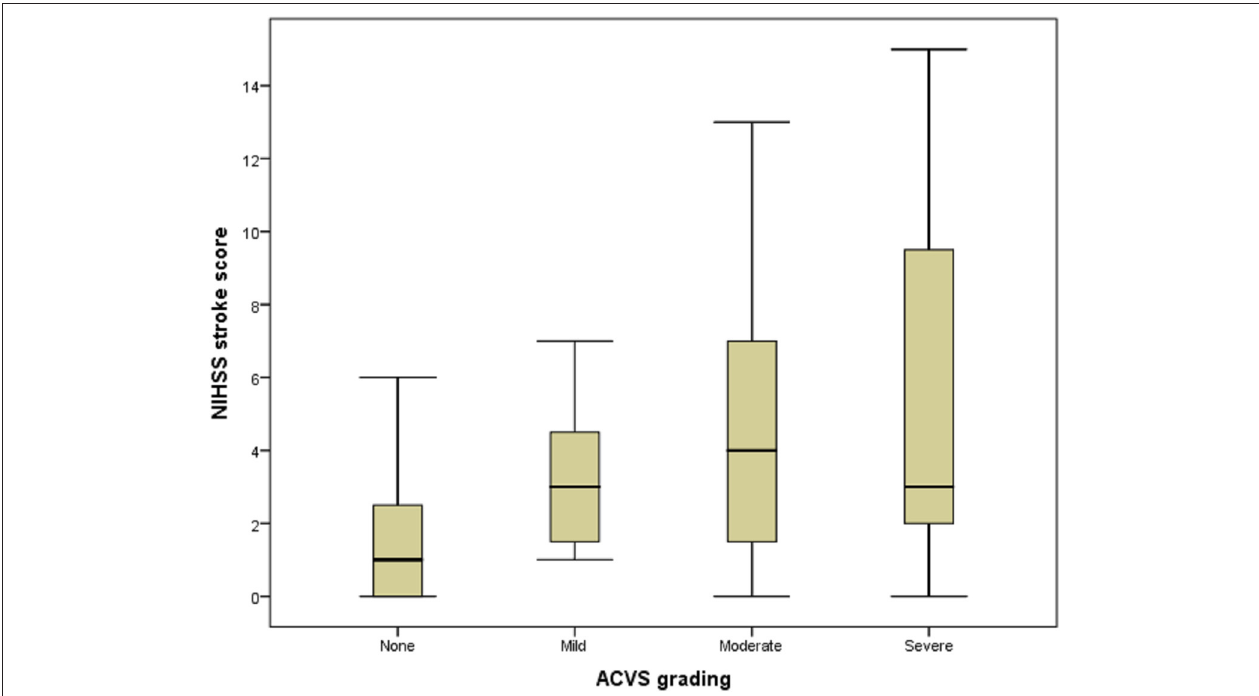
FIGURE 4 | Box plot of the relationship between ACVS and NIHSS stroke score. Box plot showing the relationship between ACVS grading (abscissa) and NIHSS stroke score (ordinate). ACVS, asymmetric cortical vein